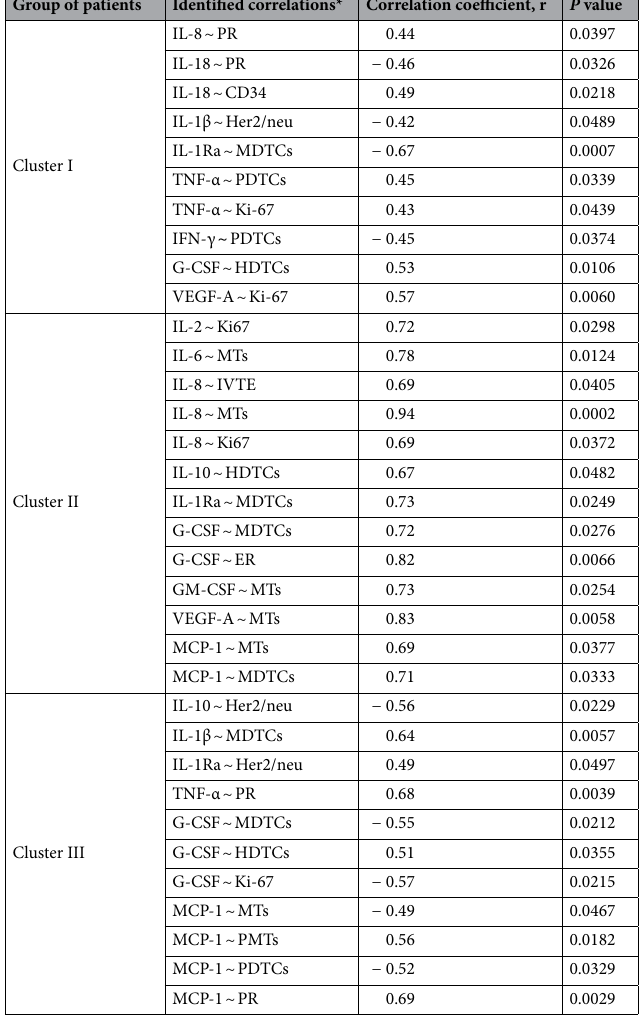
Table 3. Correlations between the parameters of cytokine production by the IBC-NST biopsy samples and histopathological characteristics of IBC-NST. *Spearman correlation